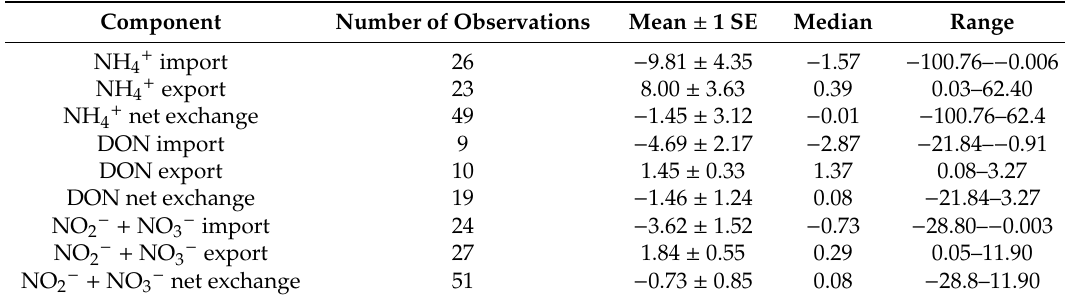
Table 5. Rates of NH 4 + , DON and NO 2 − + NO 3 − exchange between mangrove forests and adjacent tidal waterways, including mangrove-fringed estuaries. Source: [1,4,227–241] and references within. Import into the mangroves is shown as a negative value and export to adjacent tidal waters is a positive value. Units = mg N m − 2 water d − 1